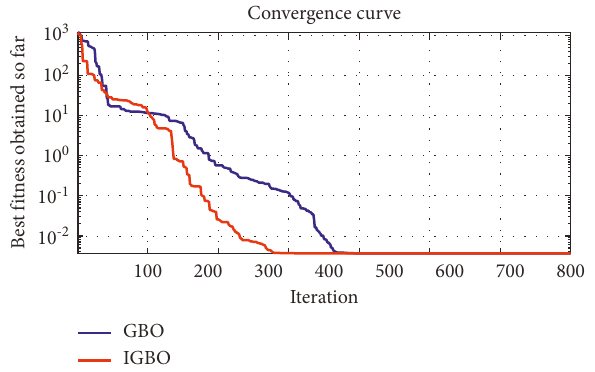
Figure 9: SAE convergence for model 4.